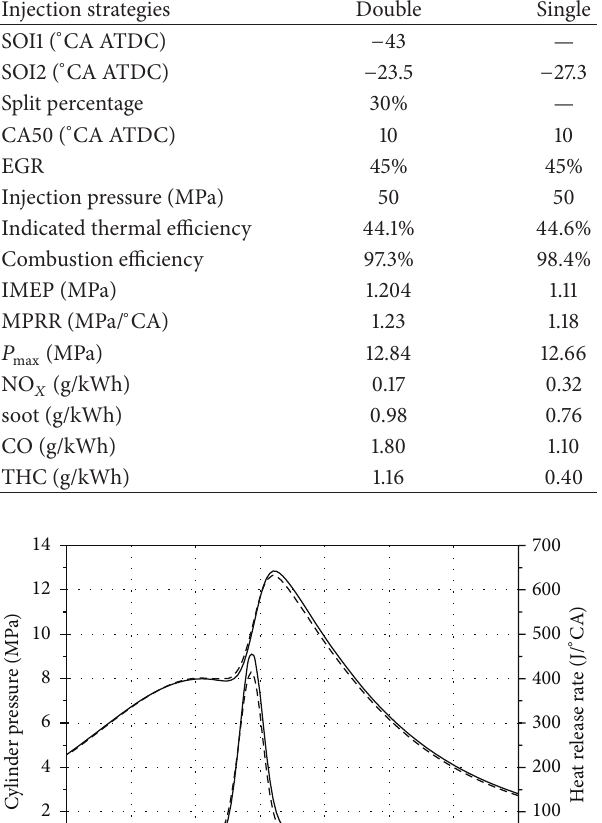
Table 3: Parameters of maximum load for different injection strategies.